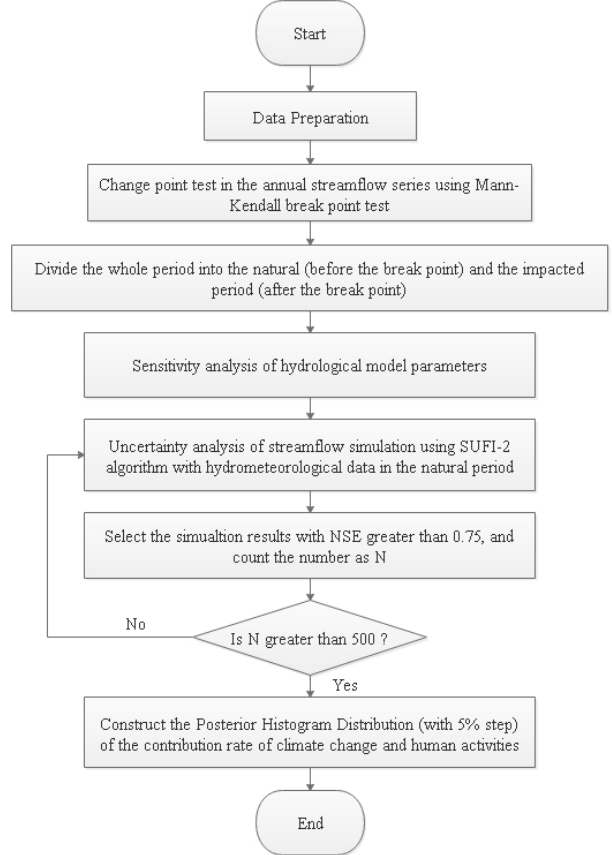
Figure 2. Flowchart of the newly proposed quantitative